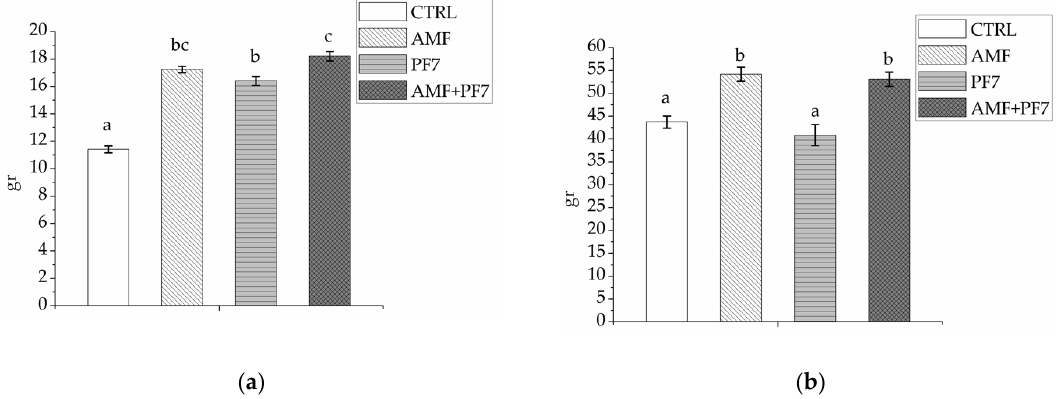
Figure 3. Average fresh weight of shoots ( a ) and roots ( b ) in the mesocosm experiment. Di ff erent letters indicated that the di ff erences among the means were significant ( p -value < 0.05). Appl. Sci. 2020 , 10 , x FOR PEER REVIEW